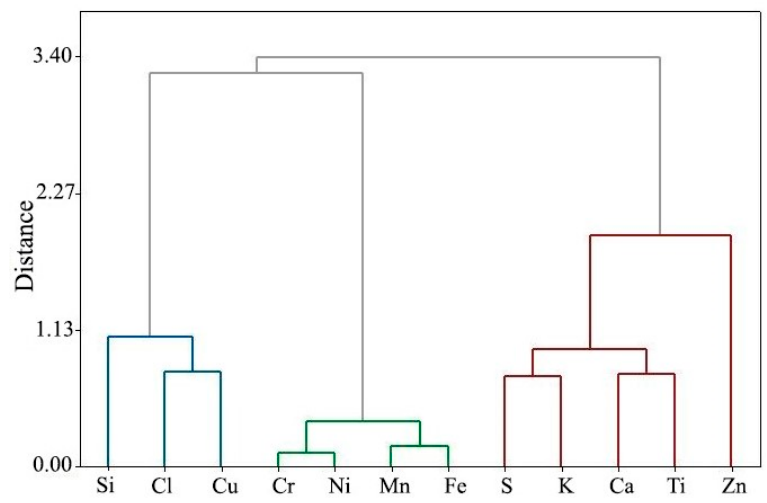
Figure 7. Dendrogram of the cluster analysis for PM 10 .